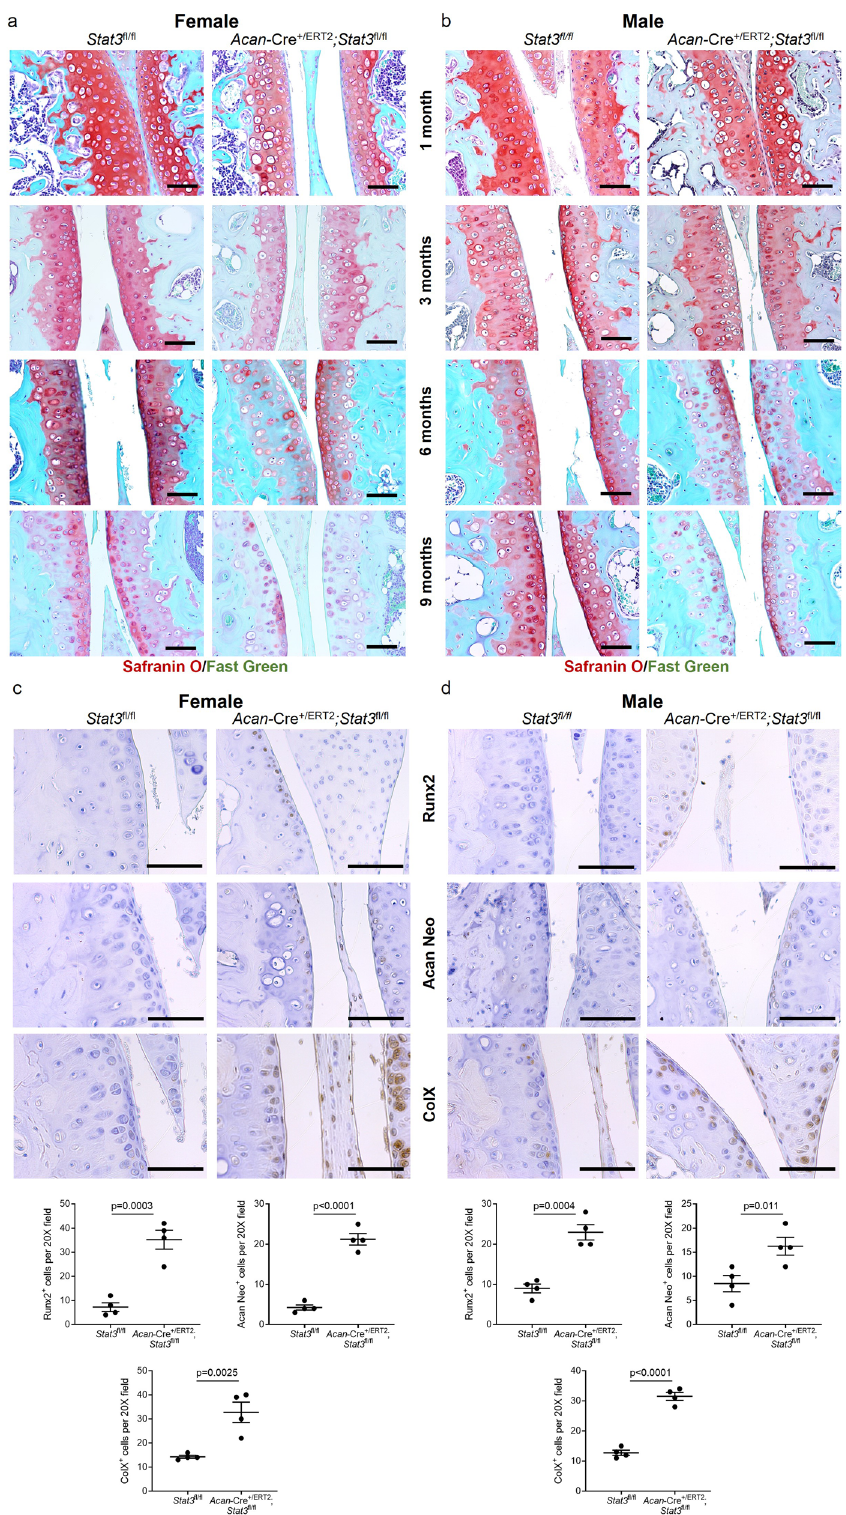
Fig. 5 Postnatal Stat3 deletion results in subtle changes in articular cartilage of the knee joint. a Administration of tamoxifen at P2/P3 to Acan - Cre + /ERT2 ; Stat3 fl / fl and control Stat3 fl / fl female and b male mice elicited reduced proteoglycan staining in articular articular cartilage by 3 months of age in female mice and by 6 months of age in males. c Histological staining and quantitative assessment of pre-hypertrophic (Runx2, collagen 10, COLX) and degenerative changes (aggrecan neoepitope, ACAN NEO) in the articular cartilage of knee joints of female and d male Stat3 deleted and control mice at 6 months. In all panels, representative images are shown and scale bars = 50 µ m. n = 4 –